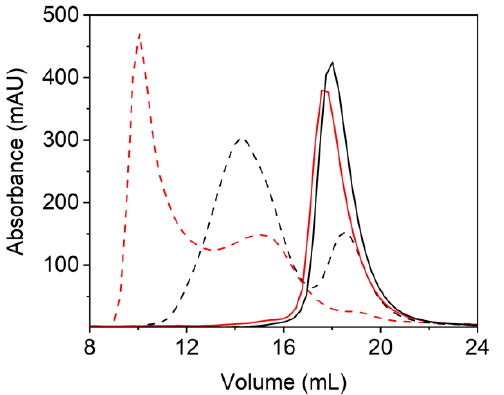
Figure 6. Heme-induced protein quaternary structure. SEC profile of HupZ ( solid black ), HupZ- heme binary complex ( dashed black ), H111A variant (solid red ), and heme-bound H111A variant ( dashed red ).